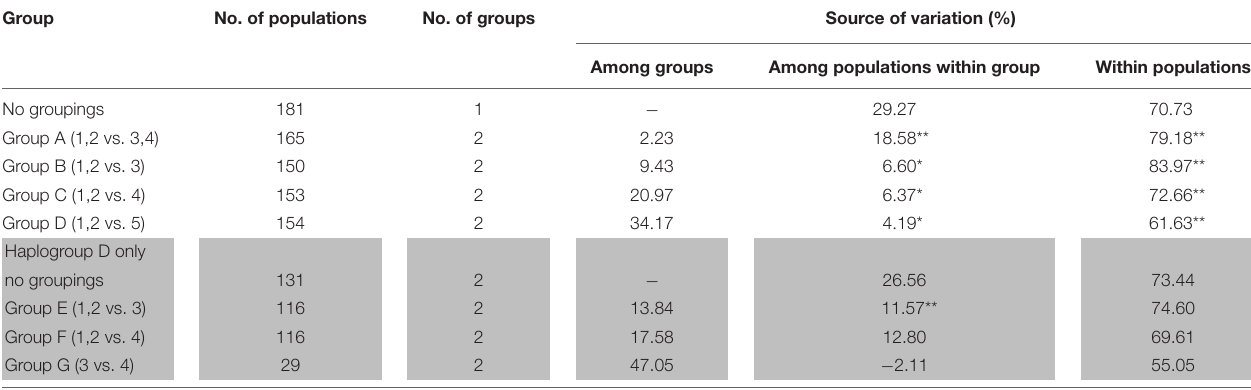
TABLE 3 | Population genetic structure estimated from the AMOVA based on complete mtDNA D-loop sequences from (1) Philippine RJFs, (2) Philippine NCs, (3) Indonesian NCs, (4) Pacific chickens, and (5) MSEA chickens. Group